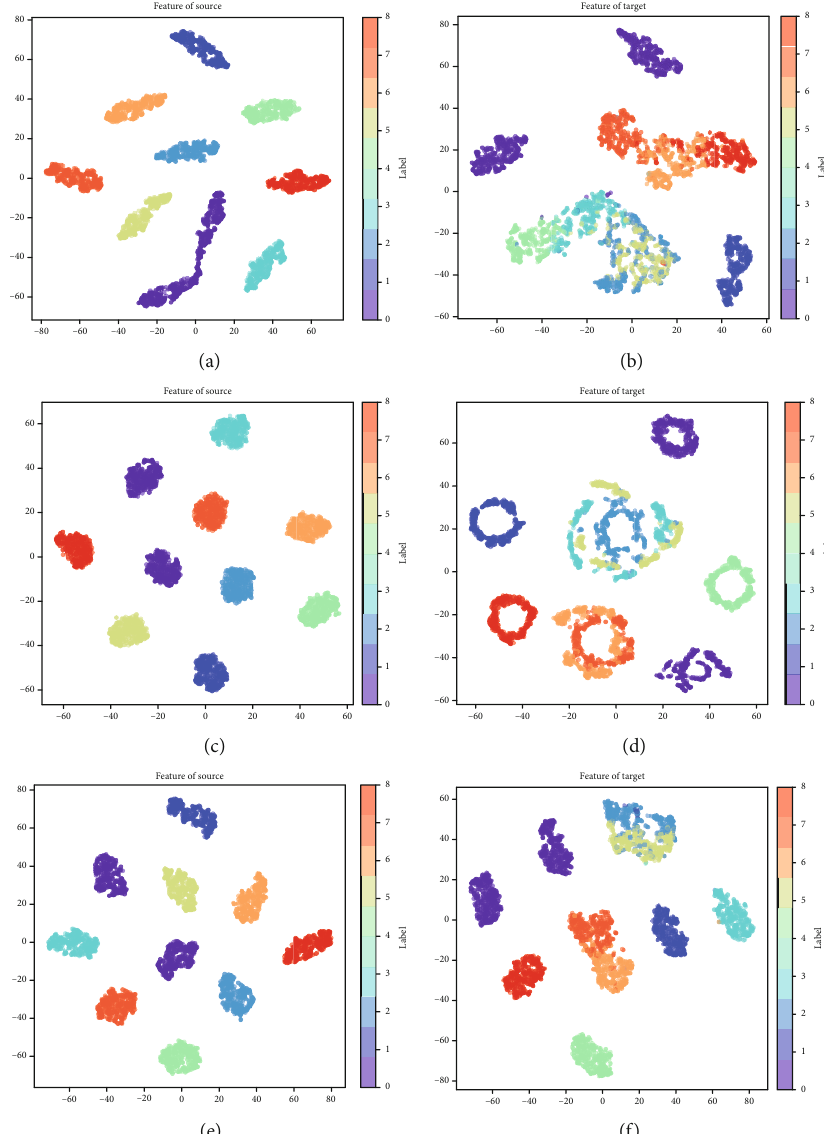
Figure 11: Visualization of features for the SEU dataset of task 1 ⟶ 0 : (a) CNN source; (b) CNN target; (c) DAN source; (d) DAN target; (e) WDATL source; (f) WDATL